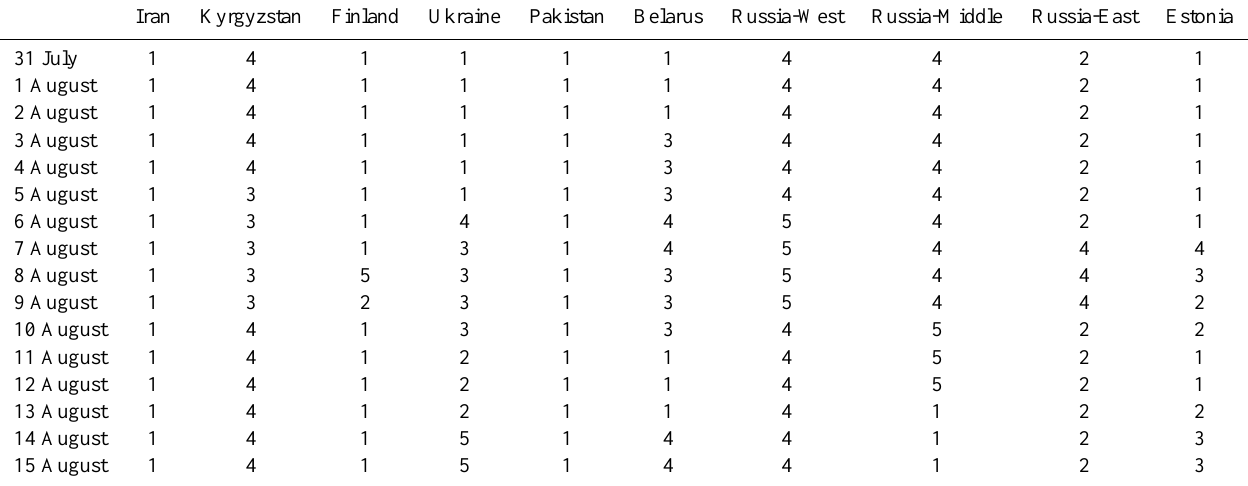
Table 3. The effect of Russian wildfires on Russia and neighbouring countries in 2010, with different numbers representing different levels. Levels 1 to 5 stand for no effect, very little effect (a negligible effect), a possible effect, a certain effect and a strong effect, respectively.